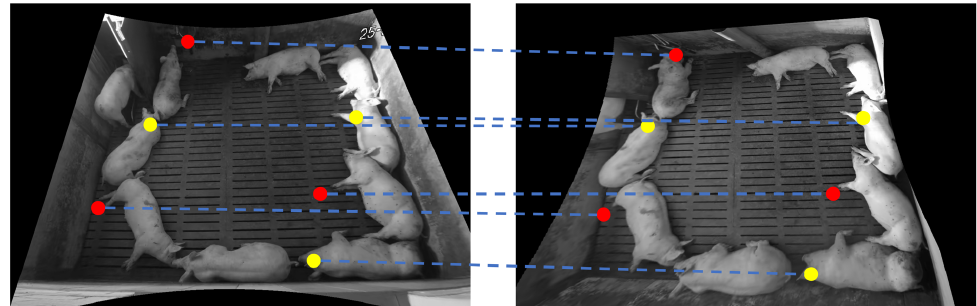
Figure 5. Examples of two types of landmarks and their correspondences. Red dots indicate back- ground objects and yellow dots indicate the